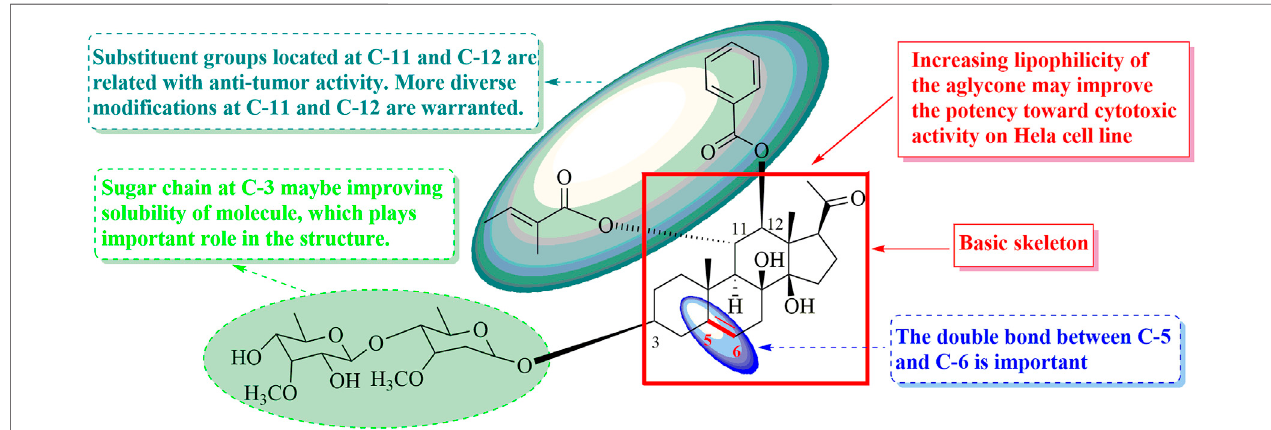
FIGURE 3 | Graphical explanation of the general SAR for cytotoxic activity of 2 and its derivatives.